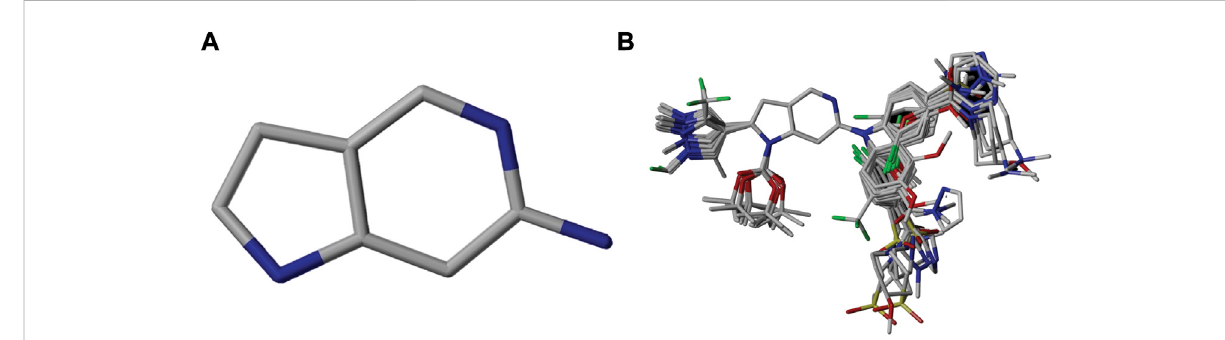
FIGURE 1 Alignment of dataset compounds: (A) Common Substructure and (B) Structure-based alignment of docked